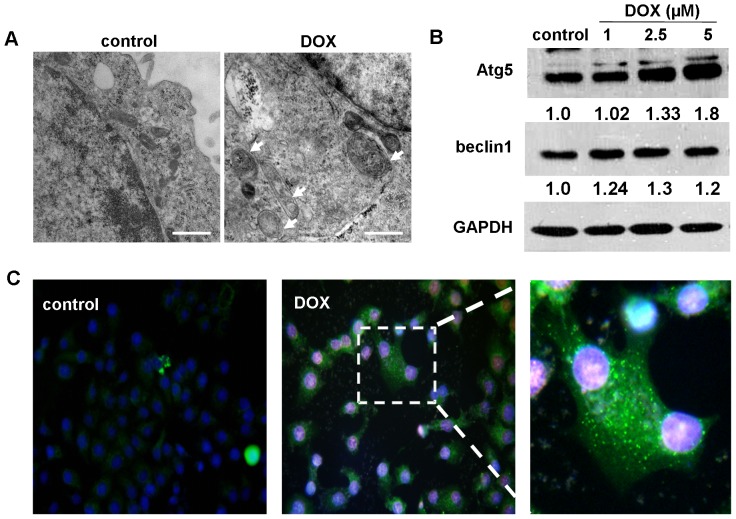
DOX treatment was found to increase autophagic activity in Hep3B cells.(A) Electron microscopic technology showed up-regulated numbers of autophagosomes in Hep3B cells treated with 2.5 µM DOX versus control. Arrows indicate autophagic structures. Scale bars represent 500 nm. Magnification, ×40000. (B) Immunoblots showed increased expression levels of Atg5 and beclin1 in Hep3B cells treated with DOX of 1, 2.5 and 5 µM for 24 h compared with control. Protein ratios normalized to GAPDH were used to quantify fold change relative to control and are shown below each blot. Data are from a representative study (n = 3). (C) Immunofluorescence analysis indicated that elevated LC3 fluorescent signals were visualized in cells administrated with 2.5 µM DOX.